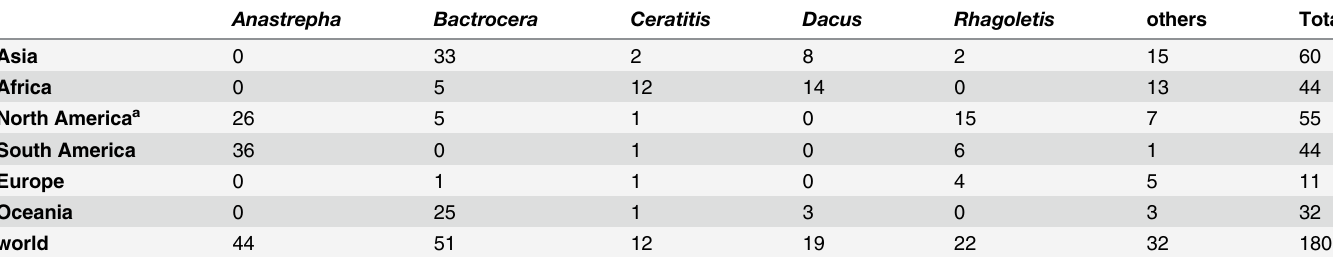
Table 1. Numbers of fruit fl y species in each continent (except for the Antarctic).